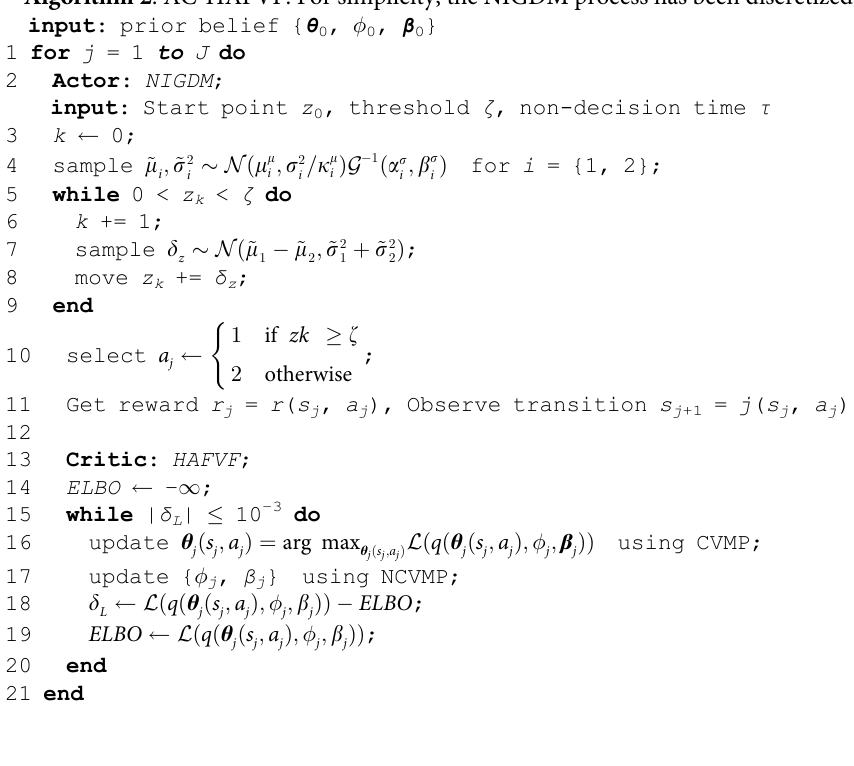
Algorithm 2 : AC-HAFVF. For simplicity, the NIGDM process has been